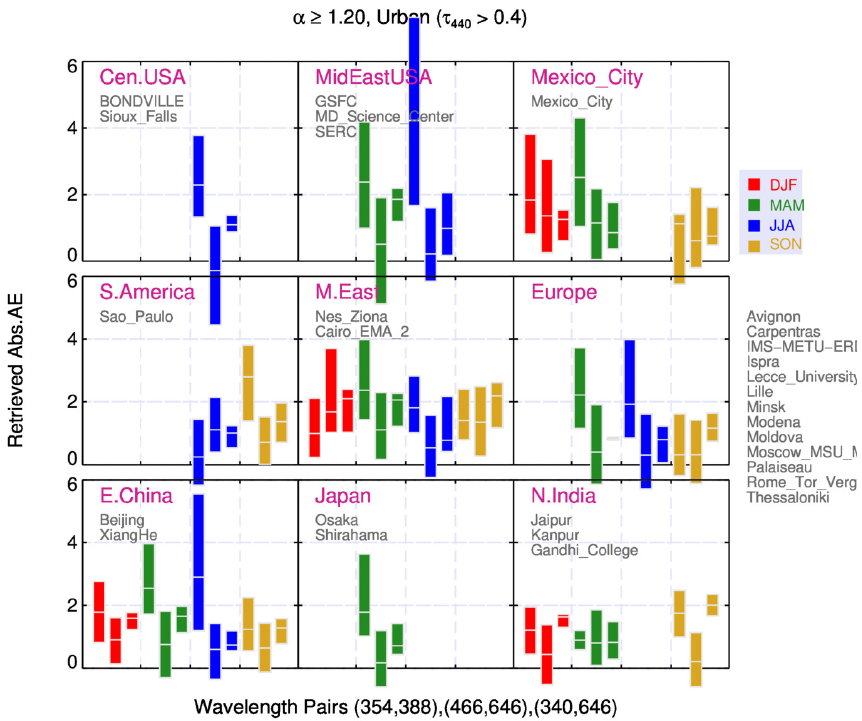
Figure 17. Absorption Ångström exponent derived at three wavelength pairs for observations with τ 440 > 0 . 4 for the fine-mode urban or mixture of aerosols. Boxplot represents the lower and upper quartile of observations with the mean as the white